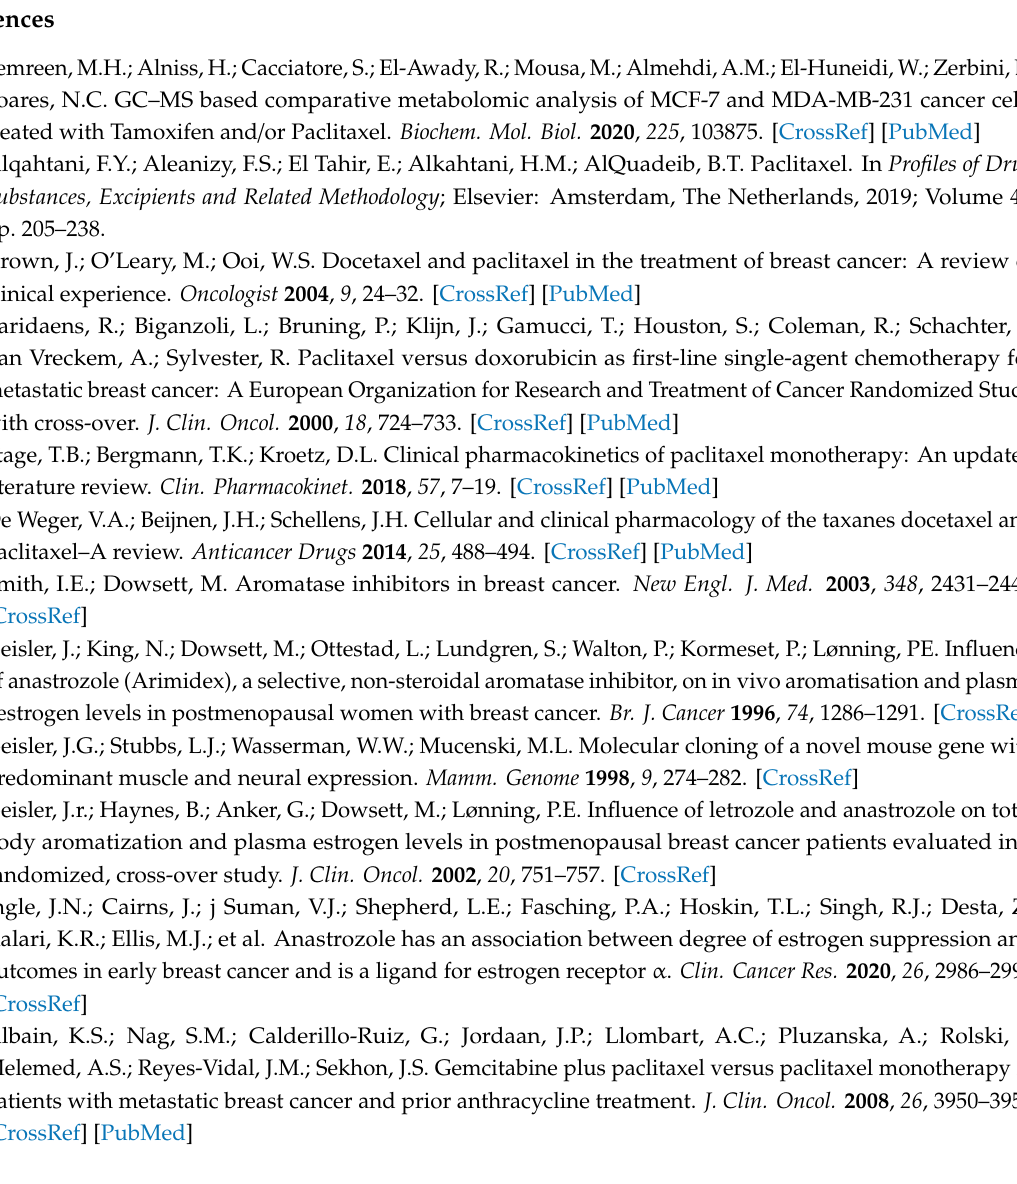
Figure S1: flow chart on the production of